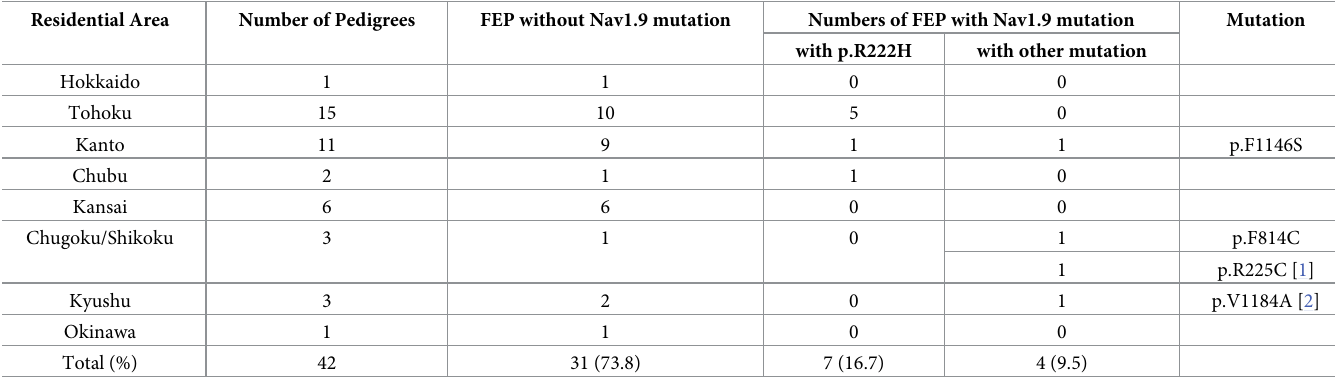
Table 1. Summary of genetic tests for